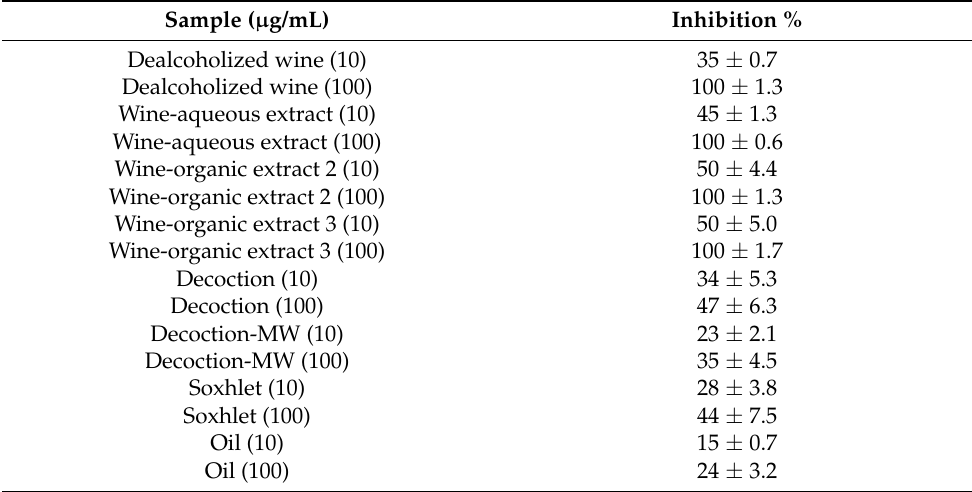
Table 9. Inhibitory effects of extracts on 5-LOX